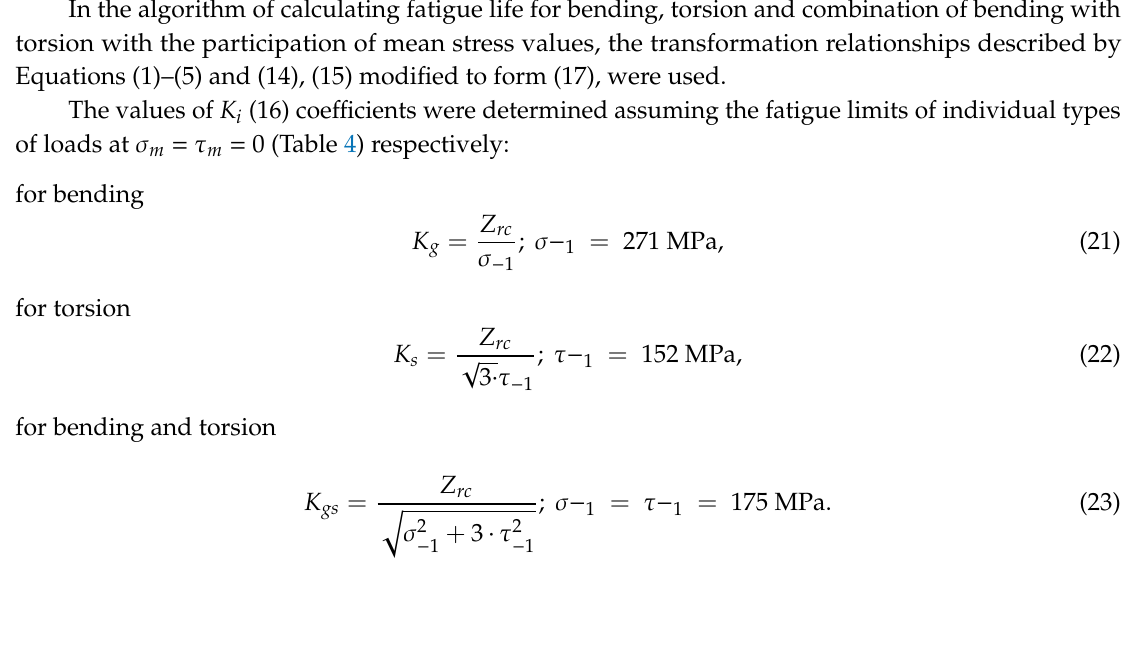
Figure 6. Change of the material sensitivity factor = f ( N ) for the asymmetry of cycle.